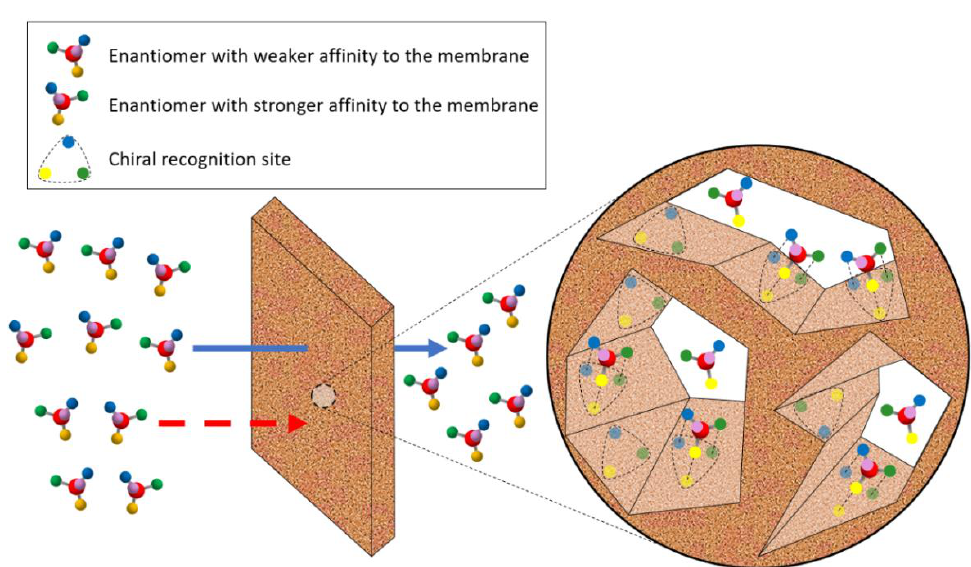
Figure 11. Chiral recognition sites in a porous solid membrane selecting a specific enantiomer.